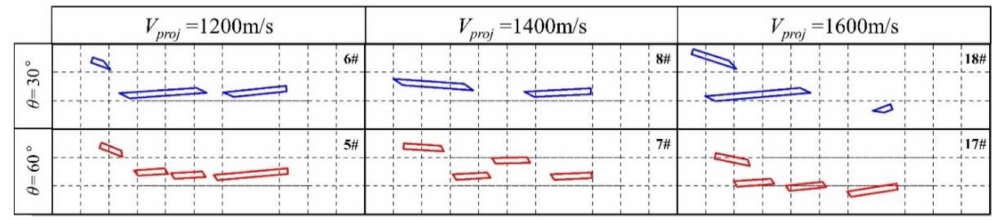
Figure 14. Location pattern of the residual fractured rod after the interaction of long rods having di ff erent velocities with di ff erent interception angles of LEFP (26